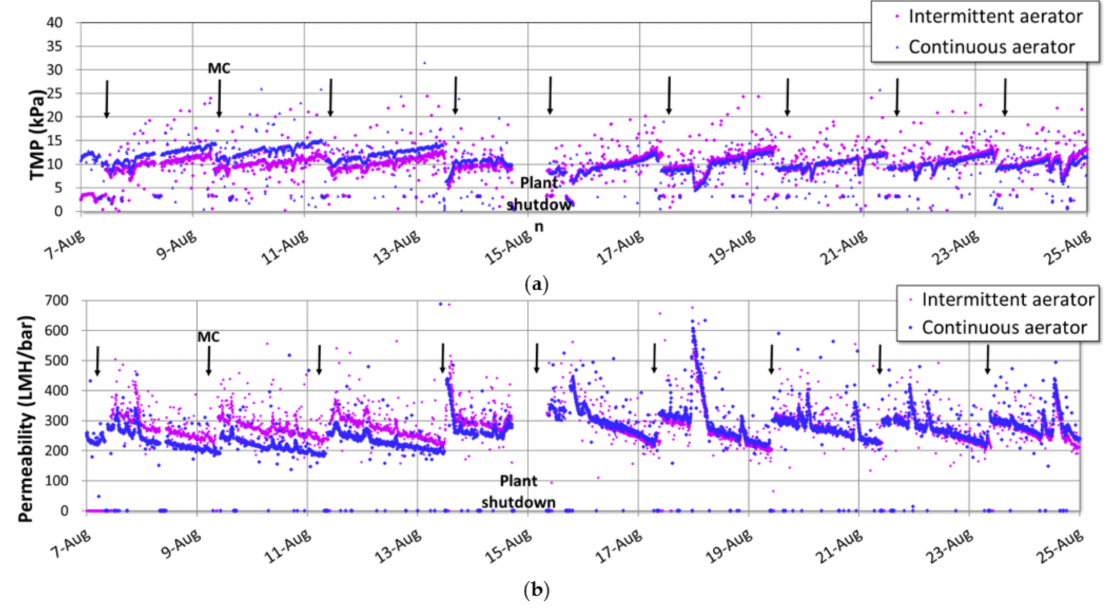
Figure 3. Comparison of aeration methods at 22 LMH flux: ( a ) TMP trend; ( b ) Permeability